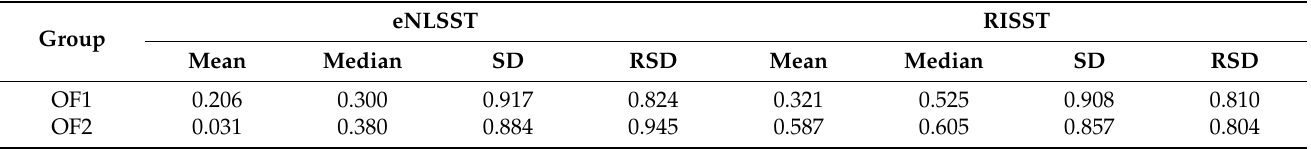
Table 3. Performance of the eNLSST and RISST algorithms with group OF1 and